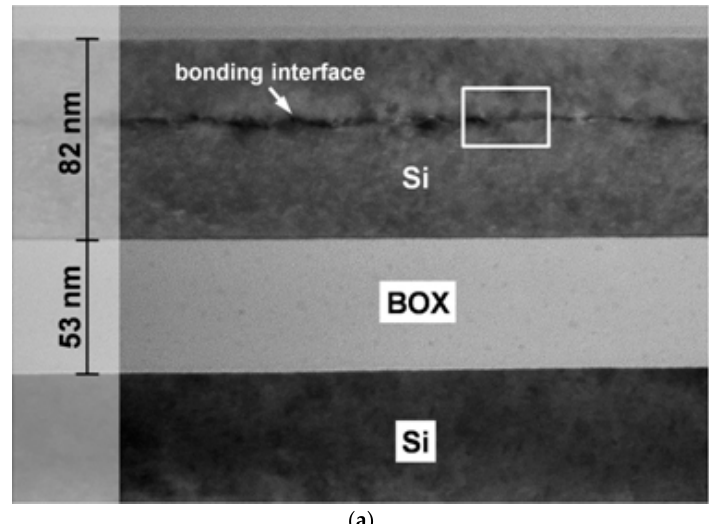
Figure 7. Cont. Figure 7.